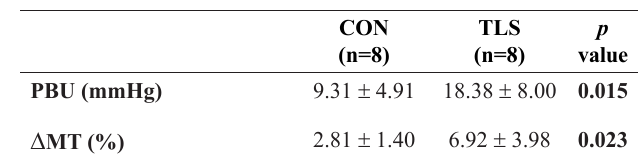
Table 1. Results (mean ± SD) for the Pressure Biofeedback Unit (PBU) test and for the variation in multifidus muscle thickness ( Δ MT) in the control (CON) and trained in lumbar stabilization (TLS)